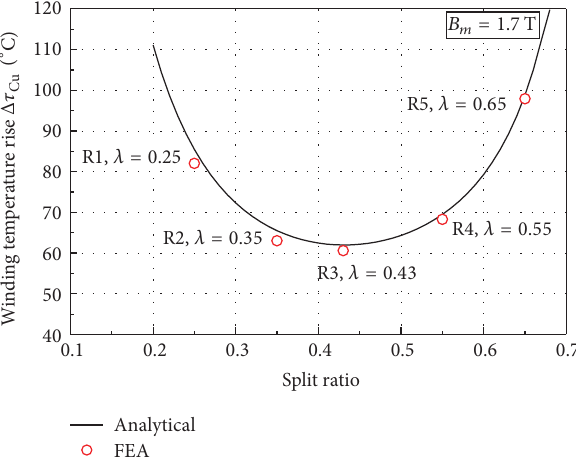
Figure 6: FEA verifications of designs R1, R2, R3, R4, and R5.